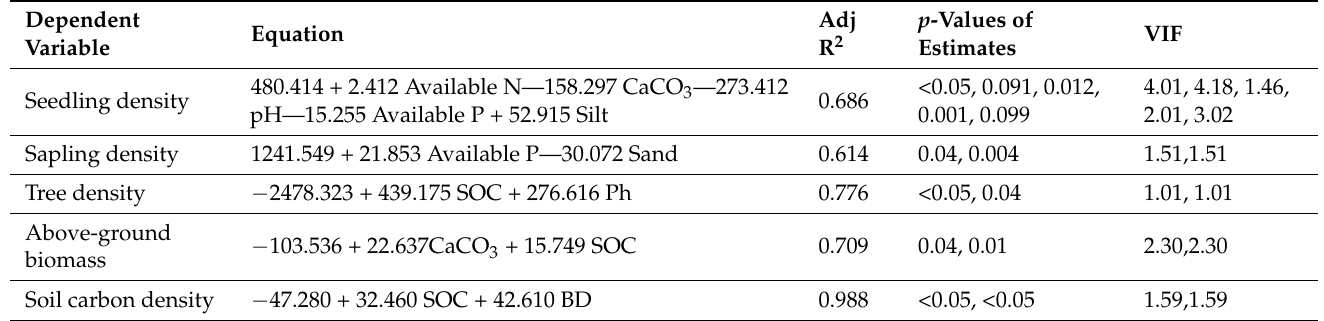
Table 3. Regression analysis between seedling, sapling, tree density (N ha −1 ), above-ground biomass and soil carbon density and the soil characteristics.